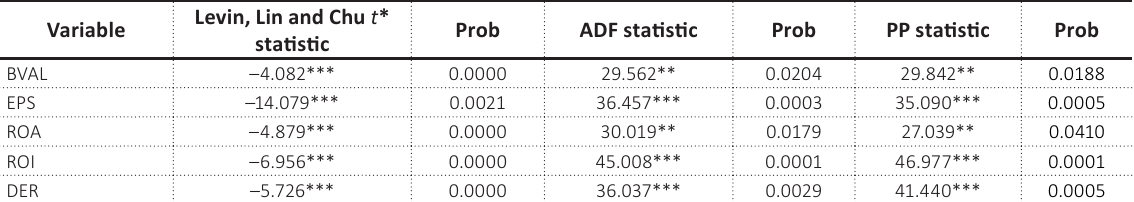
Table 3. Panel unit root